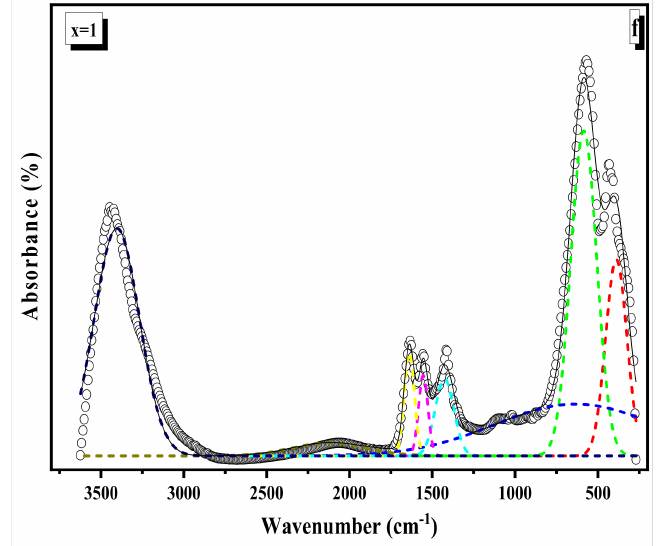
Figure 7. ( a ) FTIR spectra of Ni + 2